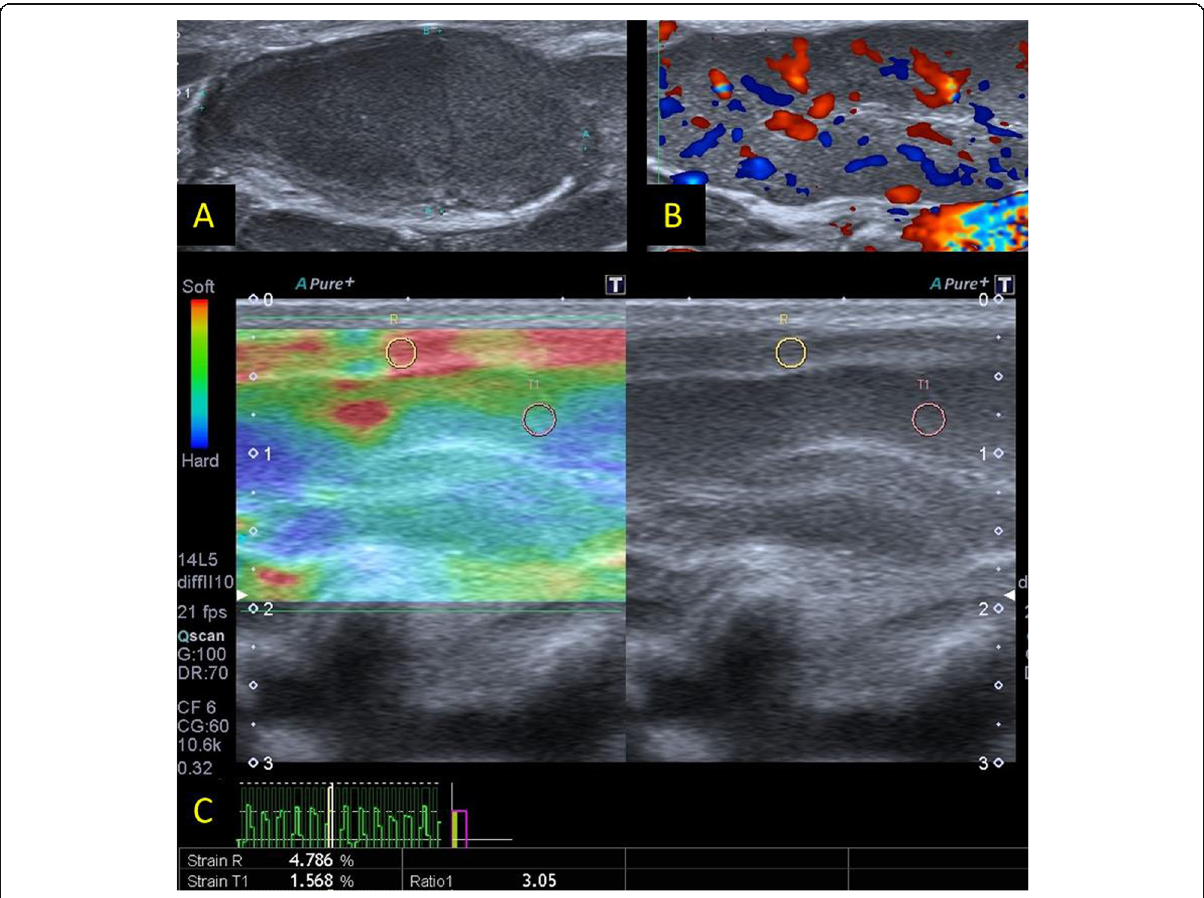
Fig. 5 B - mode US ( a ) revealed a well-defined hyporechoic left lower deep cervical lymph node with bulky cortex and thinned-out hilum. L/S ratio was 2.2. Color Doppler ( b ) revealed profuse mixed central and peripheral internal vascularity. The split-screen US elastogram ( c ) revealed type 3 color pattern. Strain ratio value was 4.7. The final histopathological diagnosis was non-Hodgkin lymphoma